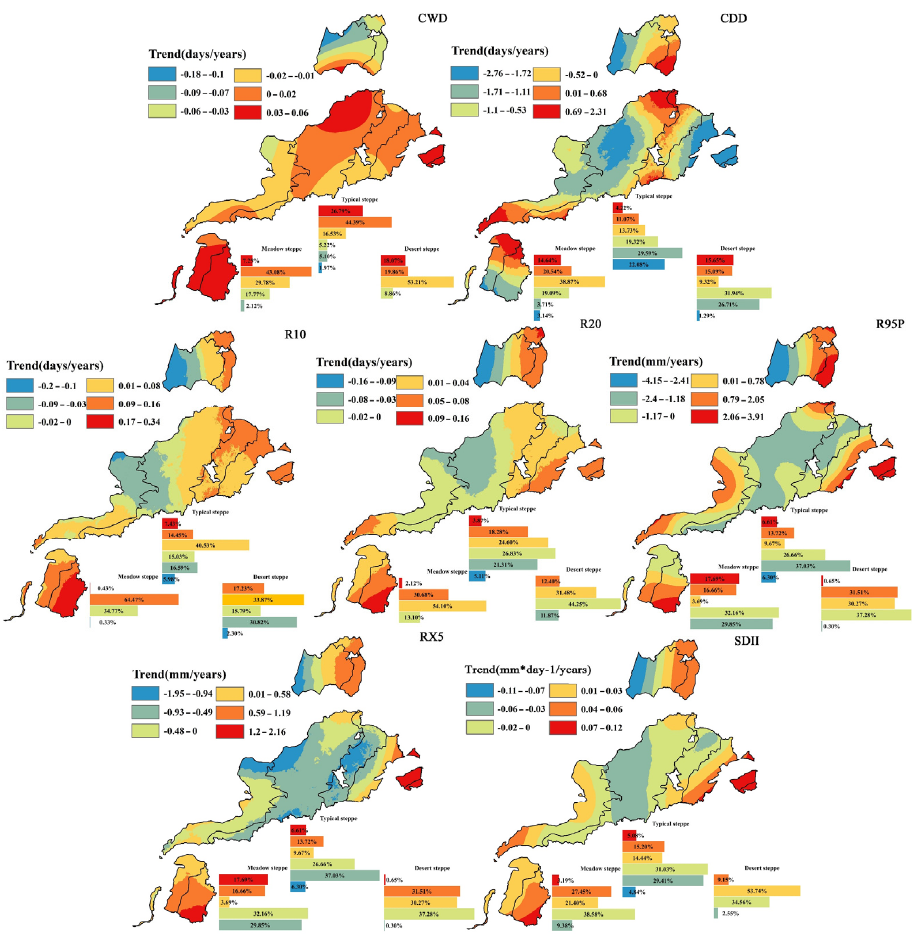
Figure 5. Spatial distribution of extreme precipitation trends in the different steppe areas of Inner Mongolia from 1998 to 2017. Indices: CDD, consecutive dry days; CWD, consecutive wet days; R10, number of heavy precipitation days; R20, number of very heavy precipitation days; R95P, very wet days; RX5, max 5-day precipitation amount; SDII, simple daily intensity